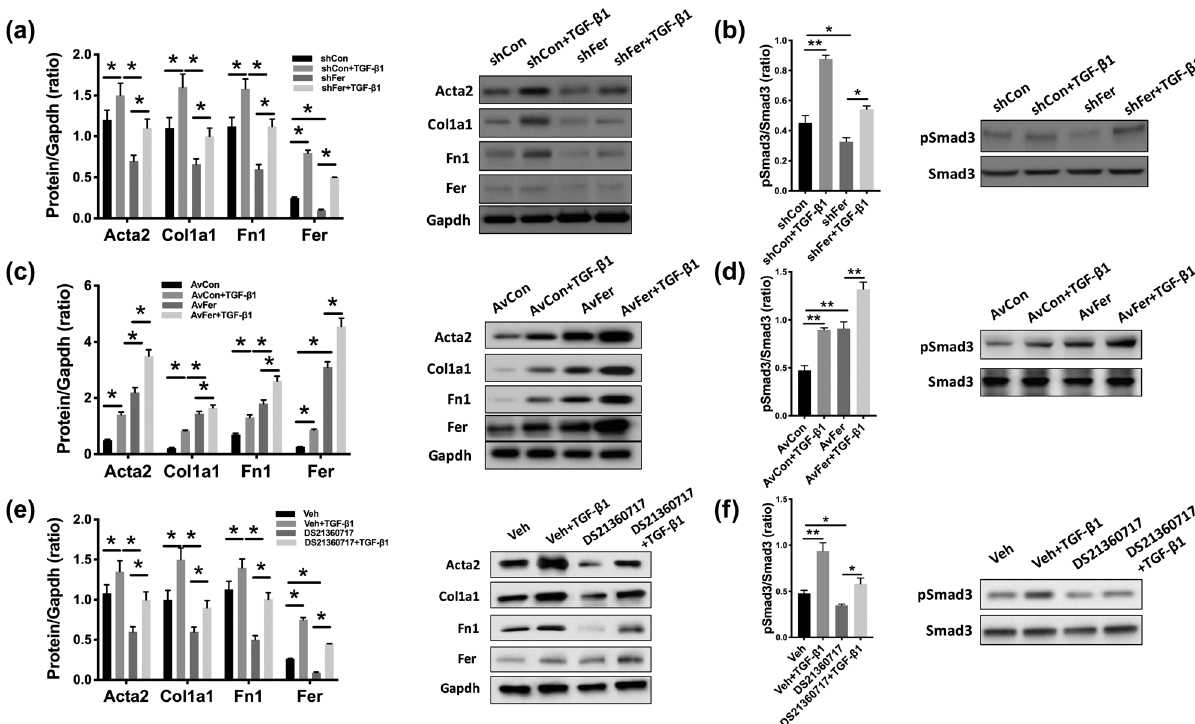
Figure 3: Inhibition of Fer restores TGF - ß1 - induced RF. Rat renal fi broblast cells NRK - 49F were modi fi ed with overexpression ( adenovirus - delivered ) and silencing ( shRNA ) of Fer and treated with TGF - β 1 ( 10 ng/mL ) for 48 h. ( a ) Expression of fi brosis - associated genes with TGF - ß1 addition and ( b ) Smad3 phosphorylation level upon Fer - KD; ( c ) expression of fi brosis - associated genes with TGF - ß1 addition and ( d ) Smad3 phosphorylation level upon Fer overexpression; ( e ) expression of fi brosis - associated genes with TGF - ß1 addition and ( f ) Smad3 phos - phorylation level upon Fer inhibition ( * P < 0.05; ** P < 0.01 )